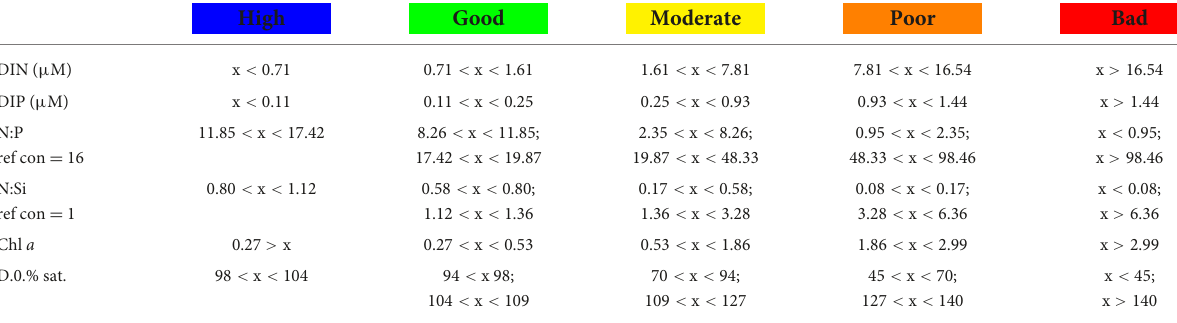
TABLE 1 Showing the calculated High to Bad boundaries for the Water Framework Directive from all the available data. High Good Moderate Poor